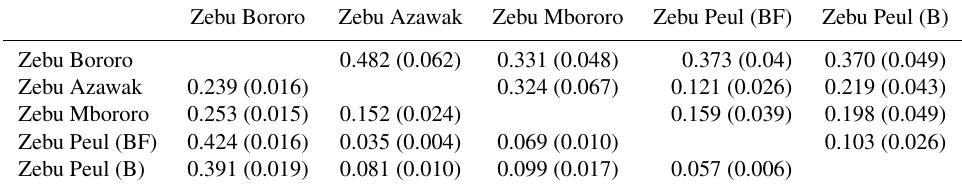
Table 5. Between-breeds Reynolds’ distance matrices computed within sex using the individual scores of 11 qualitative type traits. The distance matrix computed on the cows’ dataset are below diagonal. The distance values corresponding to the sires’ dataset are above diagonal. Standard deviations of the estimates of the Reynolds’ distance pairs (in brackets) were computed via bootstrapping using 1000 replicates. Zebu